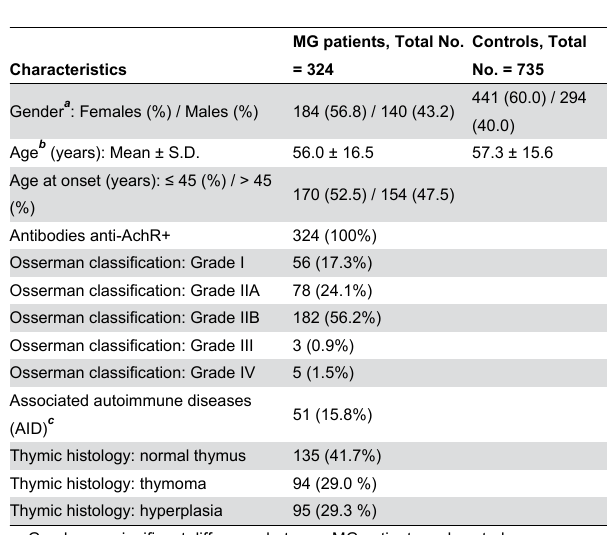
Table 1. Demographic characteristics of Myasthenia Gravis patients and